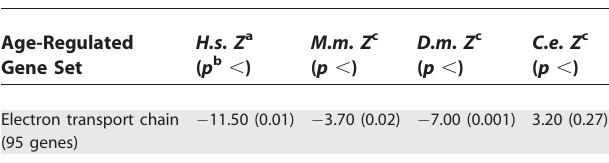
Figure 5. The Electron Transport Chain Decreases Expression with Age in Humans, Mice, and Flies Rows represent either human tissues or model organisms. Columns correspond to individual human genes and homologs to human genes defined by reciprocal best BLAST hits in other species. Scale represents the normalized slope of the change in log 2 expression level with age ( b 1j ). Data from different species were normalized by dividing the slope of expression with age by the standard deviation of all similar slopes in the dataset. Gray indicates genes were not present in that species. A navigable version of this figure showing identities of specific genes can be found at http://cmgm.stanford.edu/ ; kimlab/aging_muscle. DOI: 10.1371/journal.pgen.0020115.g005